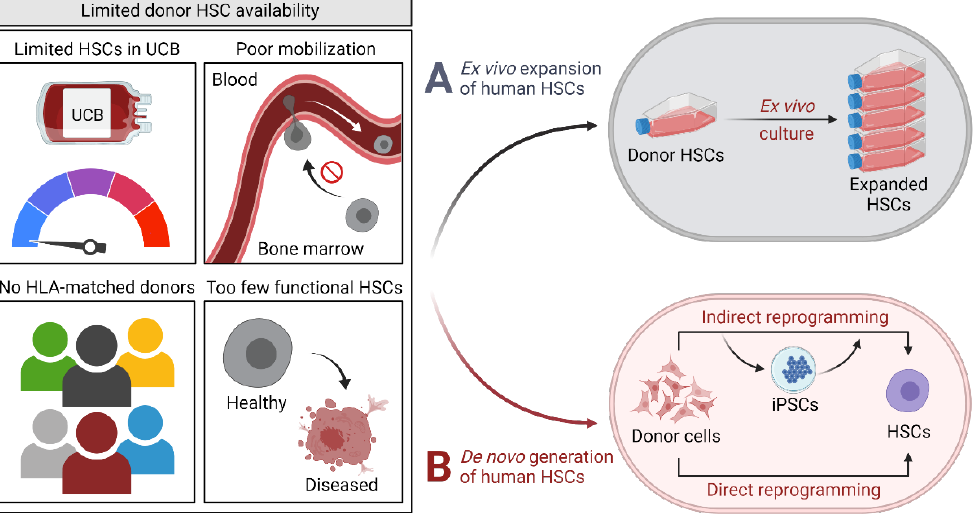
Figure 1. General approaches to increase donor hematopoietic stem cell availability for cellular therapy . Limited donor hematopoietic stem cell accessibility (e.g., due to insufficient numbers in donor umbilical cord blood units or mobilized peripheral blood cell collections, lack of human leukocyte antigen-matched donors, and poor functionality in patients with impaired hematopoiesis) may be overcome by ex vivo expansion or de novo generation by direct or indirect reprogramming of adult somatic cells. Abbreviations: UCB: umbilical cord blood; HSCs: hematopoietic stem cells; iPSCs: induced pluripotent stem cells; HLA: human leukocyte antigen.